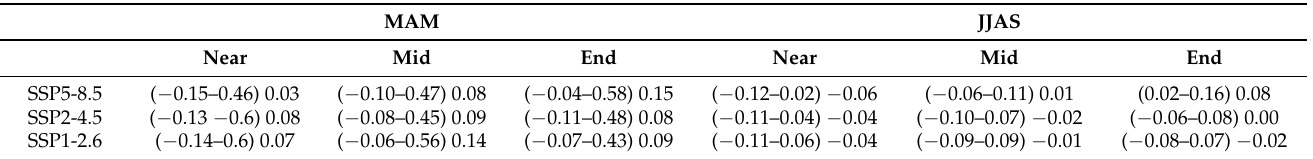
Table 9. Seasonal areal-averaged precipitation future climate change (% ∆ ) over UASB for three time periods and two scenarios.